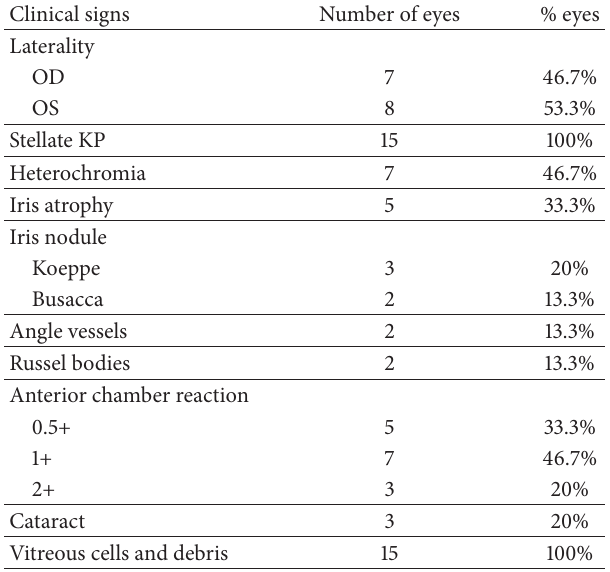
Table 2: Characteristics of patients with Fuchs’ uveitis